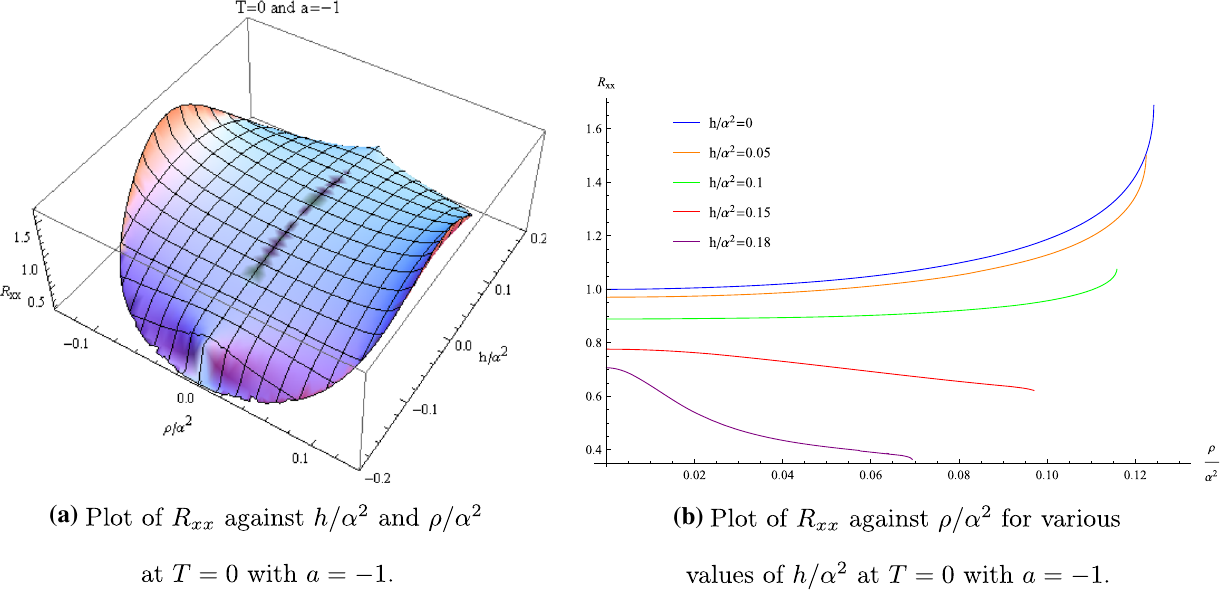
Fig. 11 Plots of R xx at T = 0 for logarithmic electrodynamics with a = − 1 Table 1 The dependence of the in-plane resistance R xx on ρ/α 2 and h /α 2 at T = 0. Here α is a parameter responsible for generating momentum dissipation. Note that ∂ | h | R xx < 0 means negative magneto-resistance while ∂ | ρ | R xx < 0 means Mott-like behavior Lagrangian Parameter ρ dependence of R xx h dependence of R xx Maxwell s ∂ | ρ | R xx < 0. See Fig. 2a. ∂ | h | R xx > 0. See Fig. 2a. There exists parameter space There exists parameter space region region for ∂ | h | R xx < 0. See for ∂ | ρ | R xx > 0. See Fig. 5. Eq.